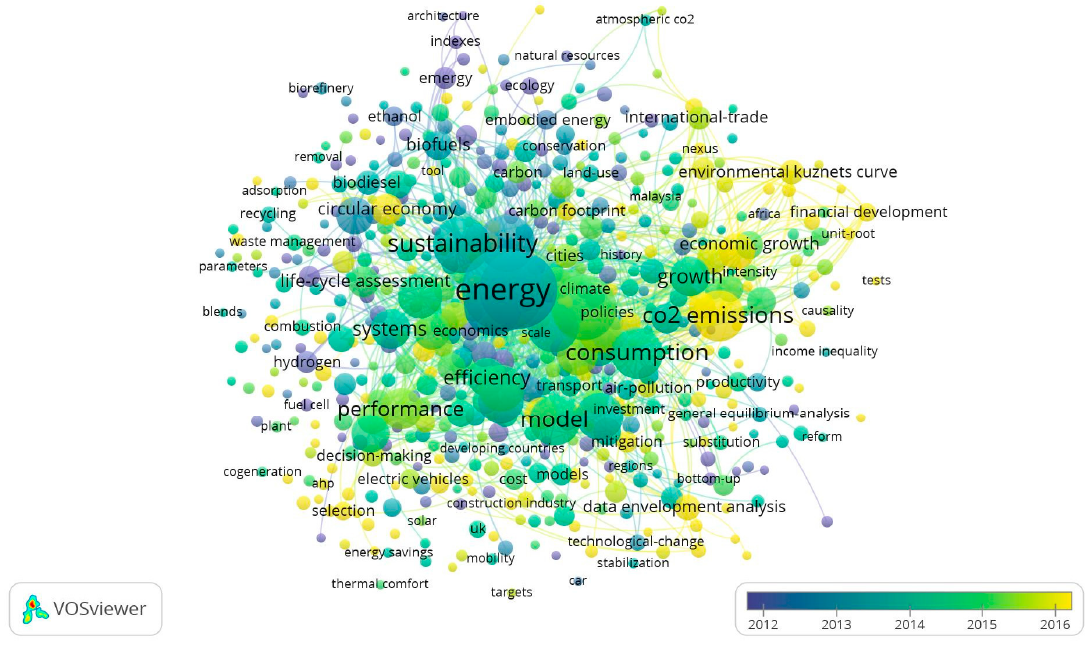
Figure 7. Keyword analysis from 2001 to 2018.